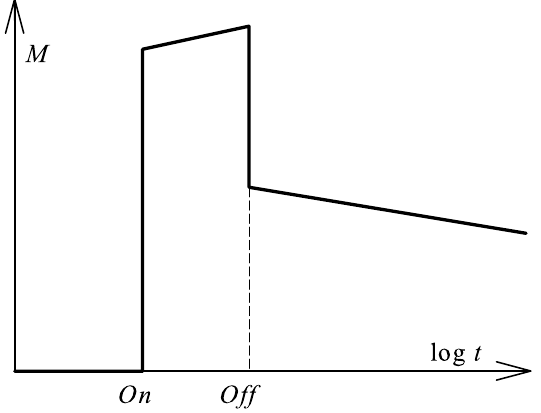
Figure 7. Magnetization M of spin glass as a function of time after turning on and off the magnetic field.